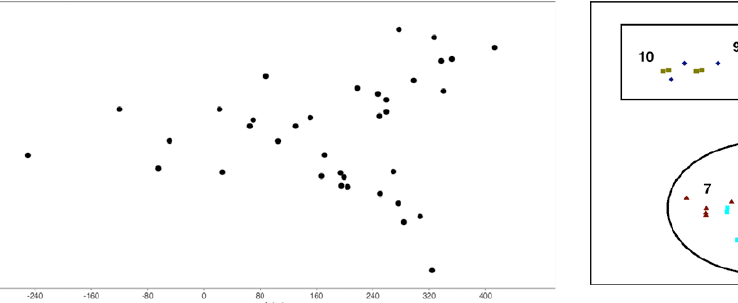
Figure 4. PCoA plot of the studied populations based on ISSR data.